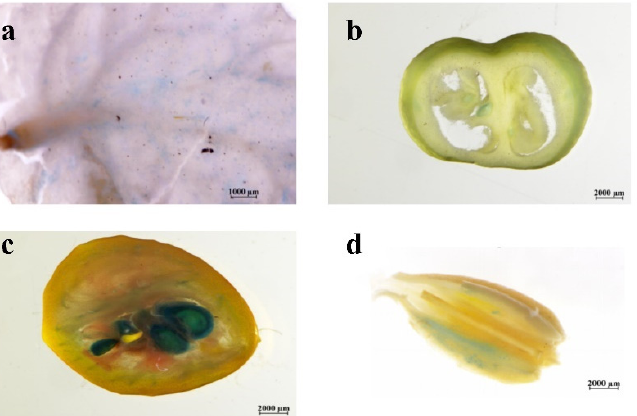
Figure 2. Histochemical localization of GUS expression patterns in SlSWEET12c-GUS transgenic tomato: ( a ) leaves; ( b ) MG fruits; ( c ) RR fruits; ( d ) flower. The scale bars correspond to 2 mm in ( b – d ) and 1 mm in a . Every experiment was repeated at least three times.